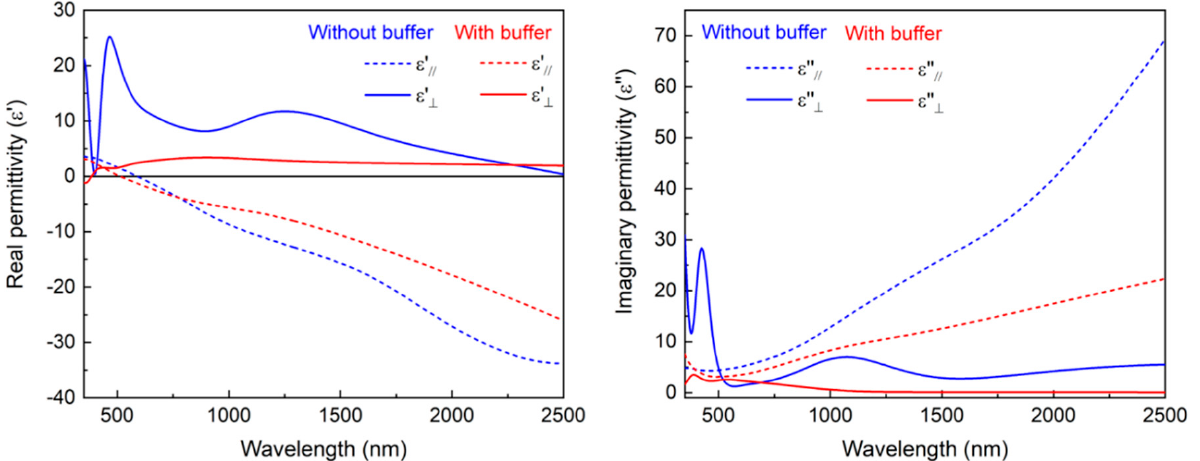
Figure 5. Real ( left ) and imaginary ( right ) parts of the in-plane and out-of-plane permittivities of the TiN–Fe nanocomposite films deposited on the bare Si and with a TiN buffer.